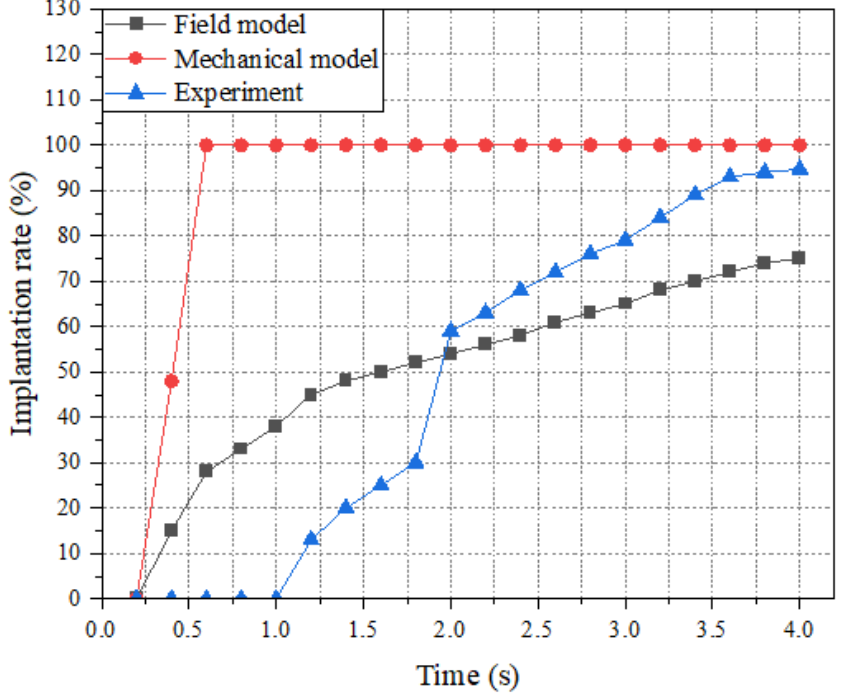
Figure 16. Abrasive implantation rate at different moments during the experiment and simulation. (30 kV, 4 Hz, 50 mm).